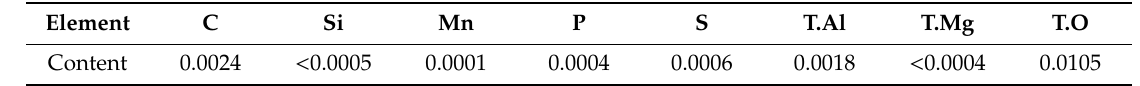
Table 2. Composition of electrolytic iron (wt. %).